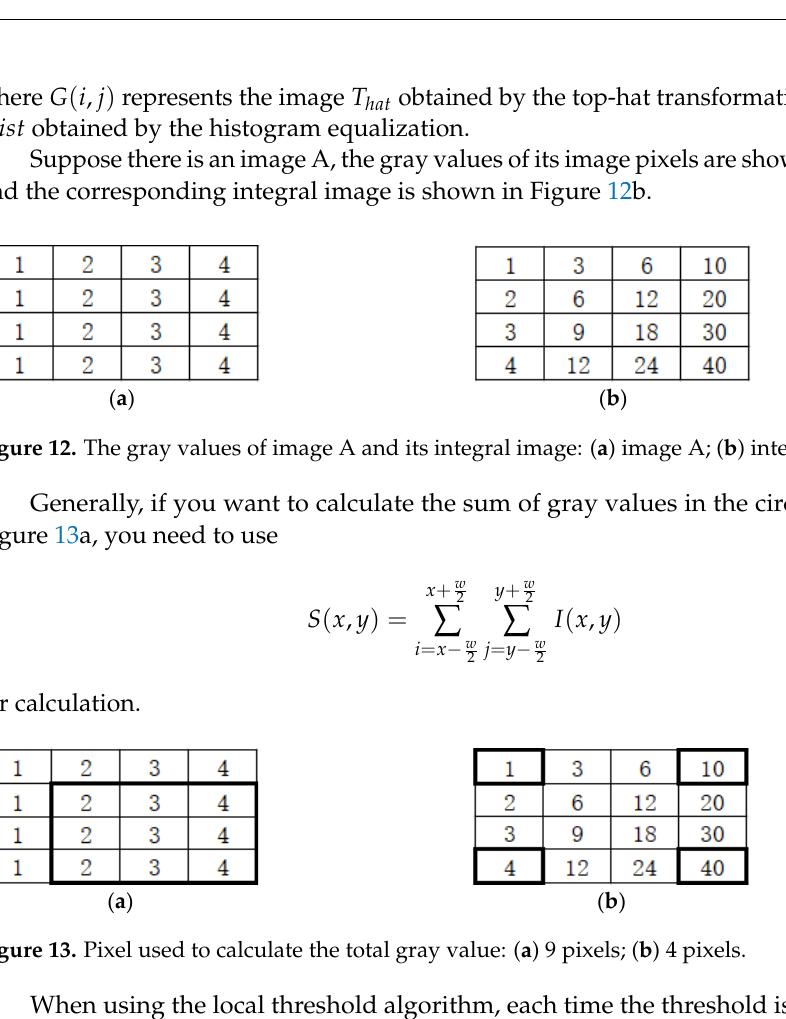
Figure 13. Pixel used to calculate the total gray value: ( a ) 9 pixels; ( b ) 4 pixels.